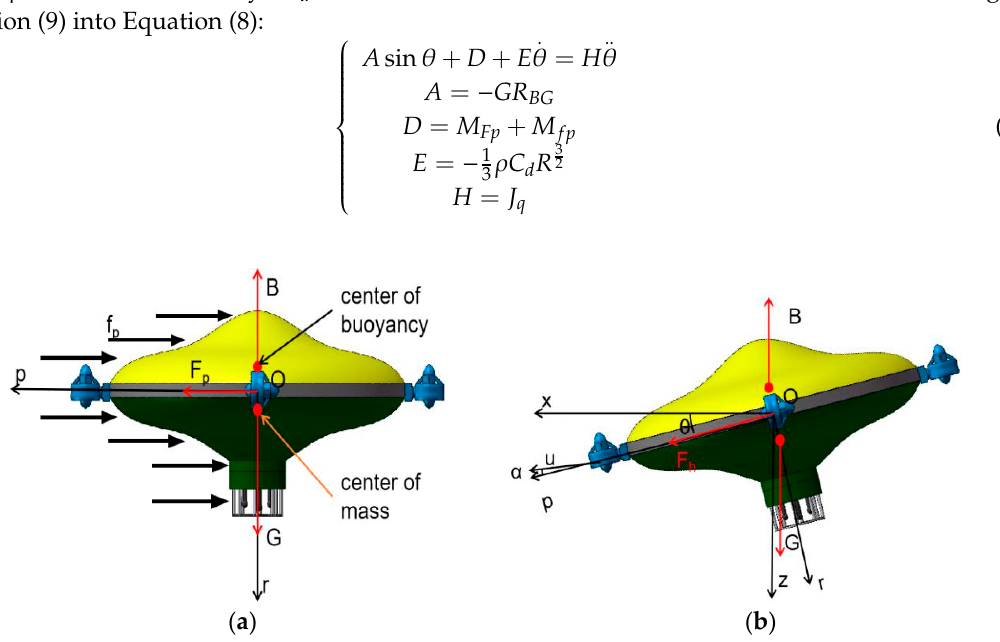
Figure 4. Force analysis of horizontal linear motion. ( a ) Initial state; ( b ) motion state.